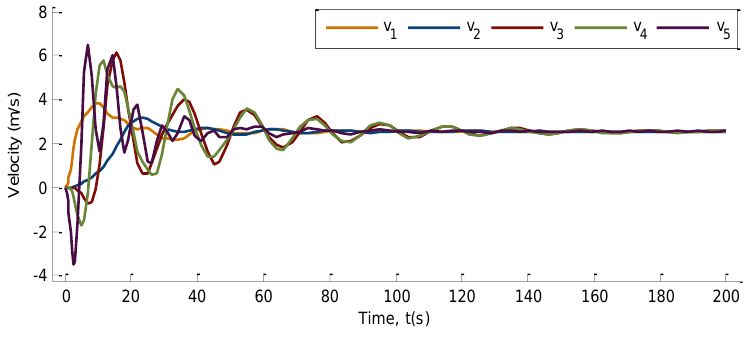
Figure 7. Velocity curves (Case